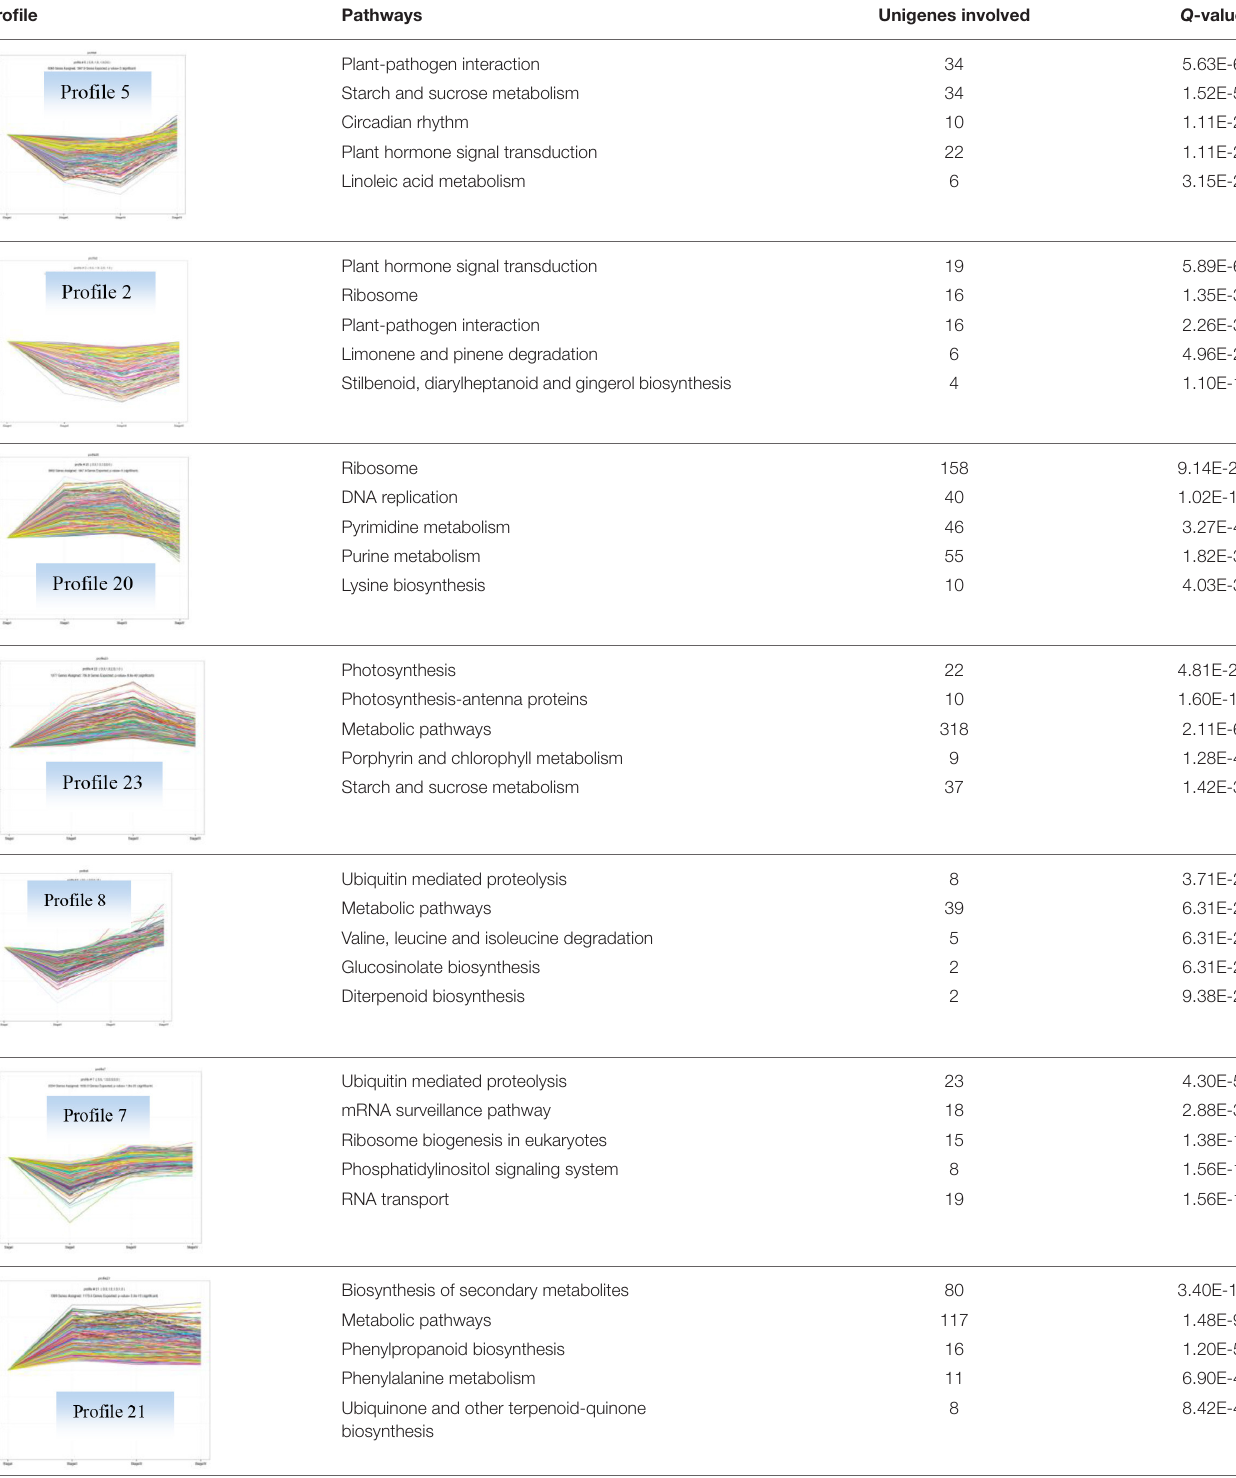
TABLE 7 | The 9 significant expression profiles and their top 5 most significantly enriched functional pathways.